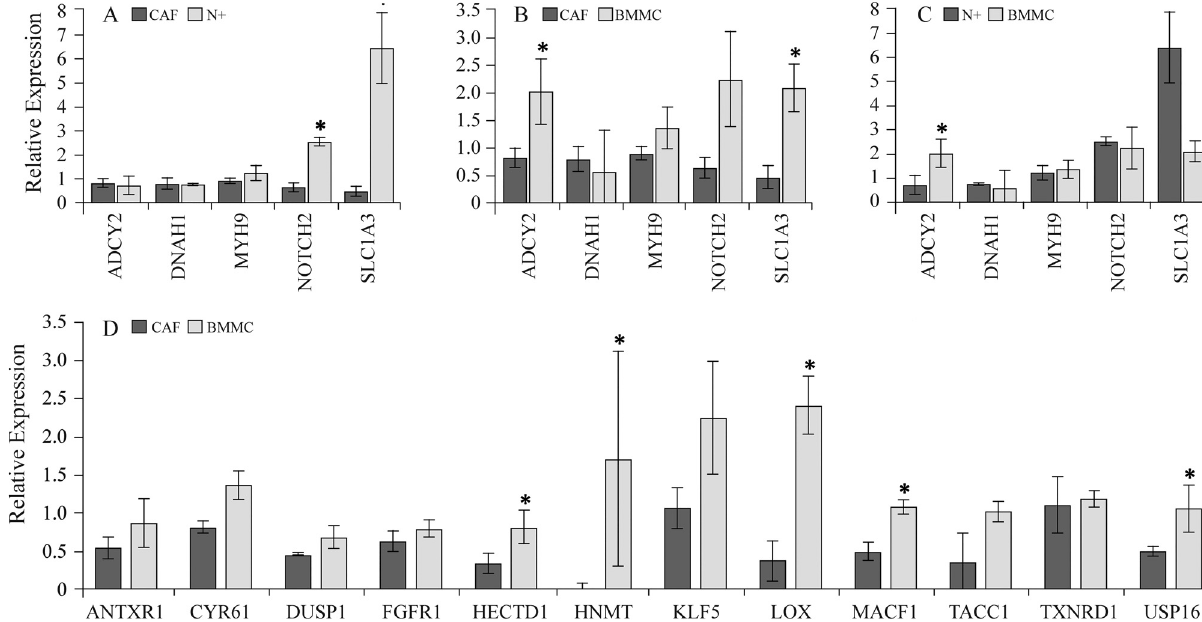
Figure 3 - Gene expression of fibroblast samples. (A) Primary tumor (CAF, n = 6 or 7) vs. lymph node (N+, n = 3 or 4). (B) Primary tumor (CAF, n = 6 or 7) vs. bone marrow (BMMC, n = 3 or 4). (C) Lymph node (N+, n = 3 or 4) vs. bone marrow (BMMC, n = 3 or 4). (D) Primary tumor (CAF, n = 3) vs. bone marrow (BMMC, n = 3). Relative expression based on 2 - (cid:4)(cid:4) Ct . PPIA was used as a reference gene, and average Ct values for the same transcript were used as the sample reference. Bars represent mean (cid:5) SE. *p (cid:6) 0.05 (Mann-Whitney